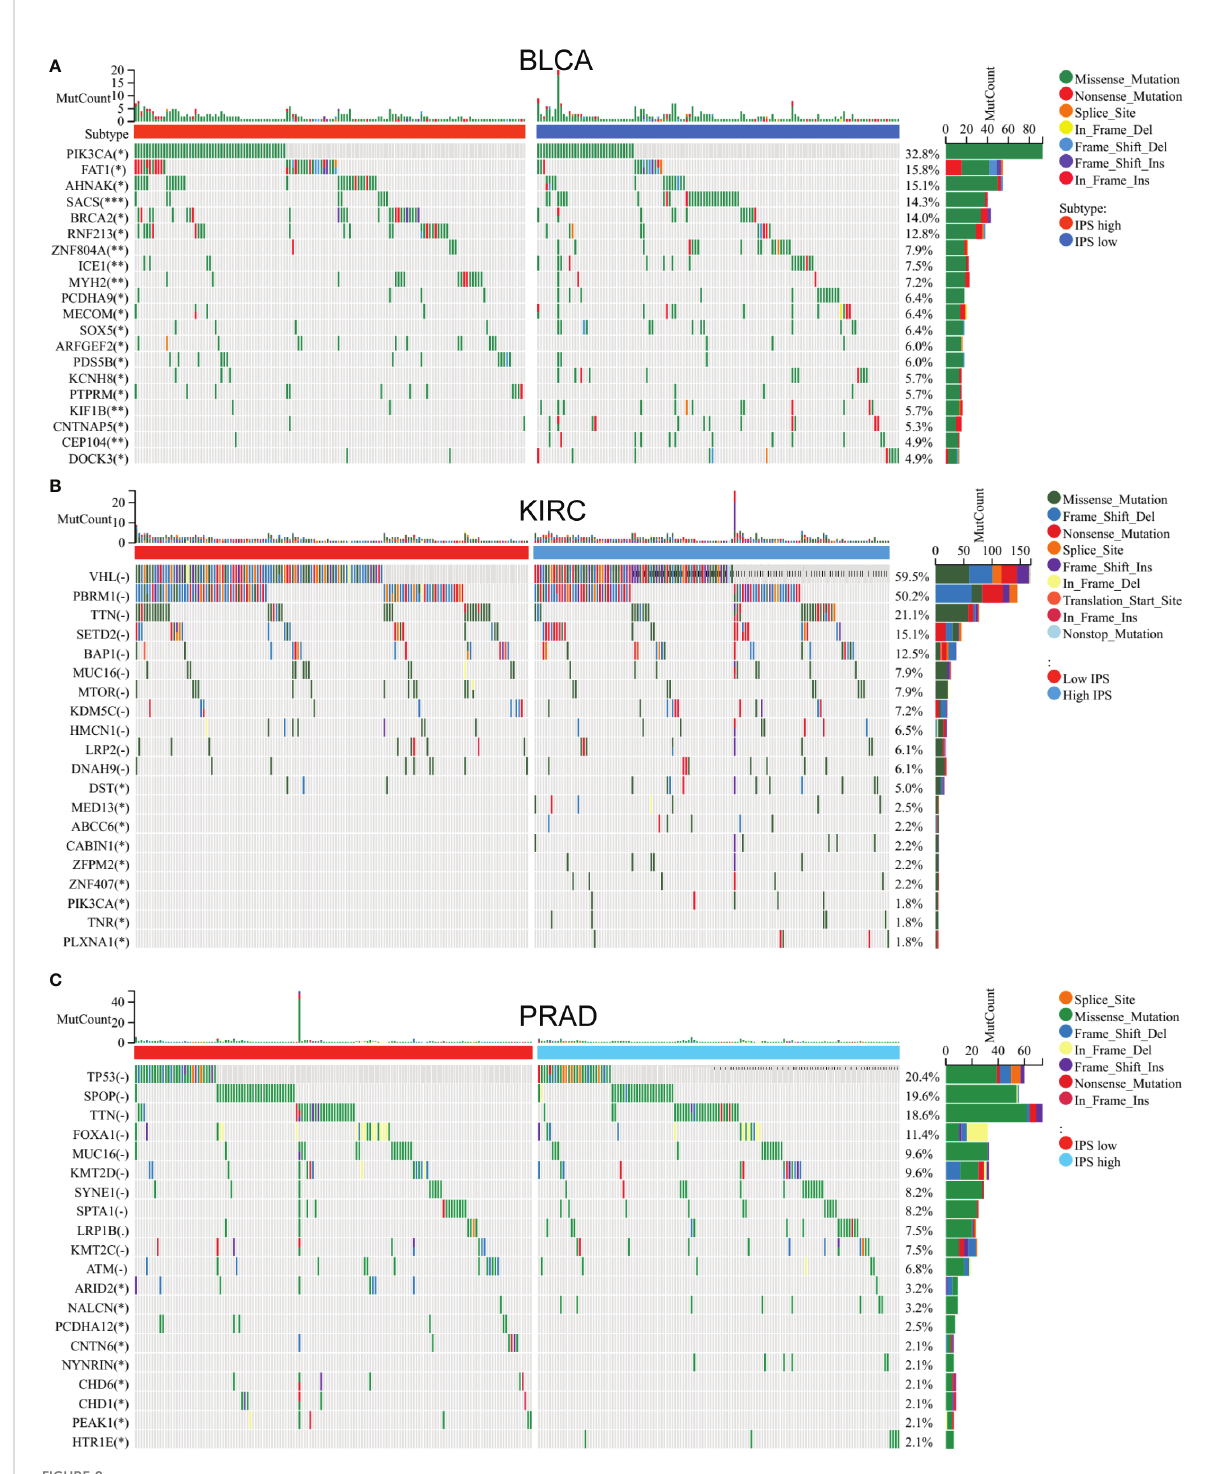
FIGURE 8 Mutation gene difference between low IP - score and high IP - score. Mutation gene difference between low IP - score and high IP - score in (A) Bladder carcinoma. (B) Kidney renal clear cell carcinoma. (C) Testicular Germ Cell